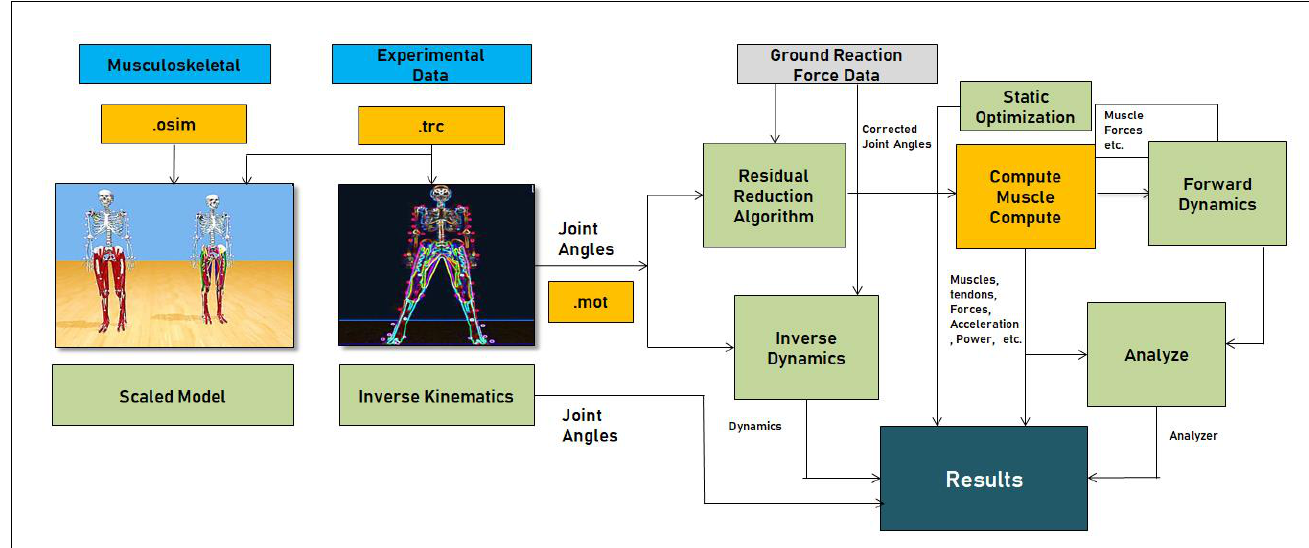
Figure 2. Overview of OpenSim